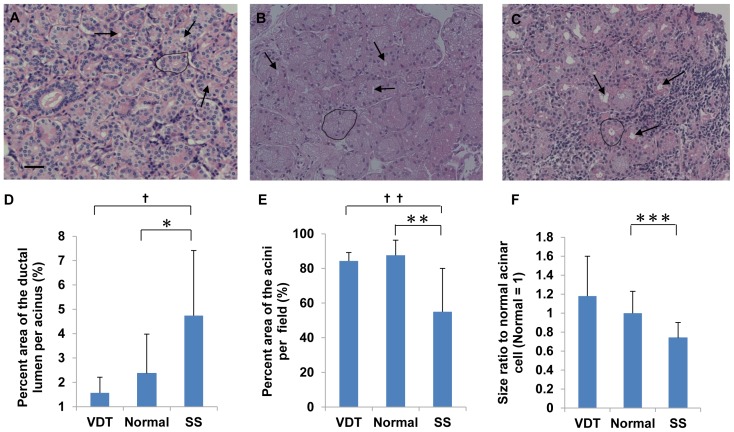
Lacrimal gland histology by H&E staining.(A) H&E staining of lacrimal gland from normal controls (n = 9). (B) H&E staining of lacrimal gland from the VDT group (n = 4). (C) H&E staining of lacrimal gland from the SS group (n = 13). Arrows indicate ductal lumens. Circle indicates one acinus. Scale bars = 50 µm. (D) Percent area of the ductal lumen per acinus. Total number of acini examined/group: 879/VDT group (4 cases), 2241/SS group (13 cases), and 1869/Normal controls (9 cases). *P = 0.03, †
P = 0.013 (Mann-Whitney U test). (E) Percent area of the acini per field. Number of fields/group: 12/VDT group (4 cases), 39/SS group (13 cases), and 27/Normal controls (9 cases). **P = 0.001, ††
P = 0.013 (Mann-Whitney U test). (F) Acinar cell size relative to that of normal acinar cells. Number of cells measured/group: 6668/VDT group (4 cases), 19021/SS group (13 cases), and 17325/Normal controls (9 cases). ***P = 0.01 (Mann-Whitney U test). Original magnification: ×200 (A–C).